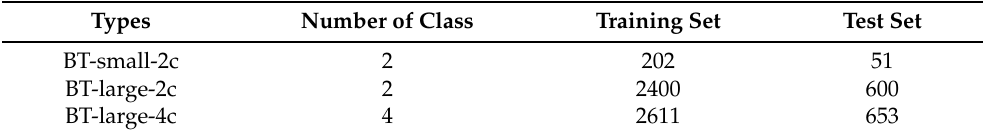
Table 3. Details of the dataset.